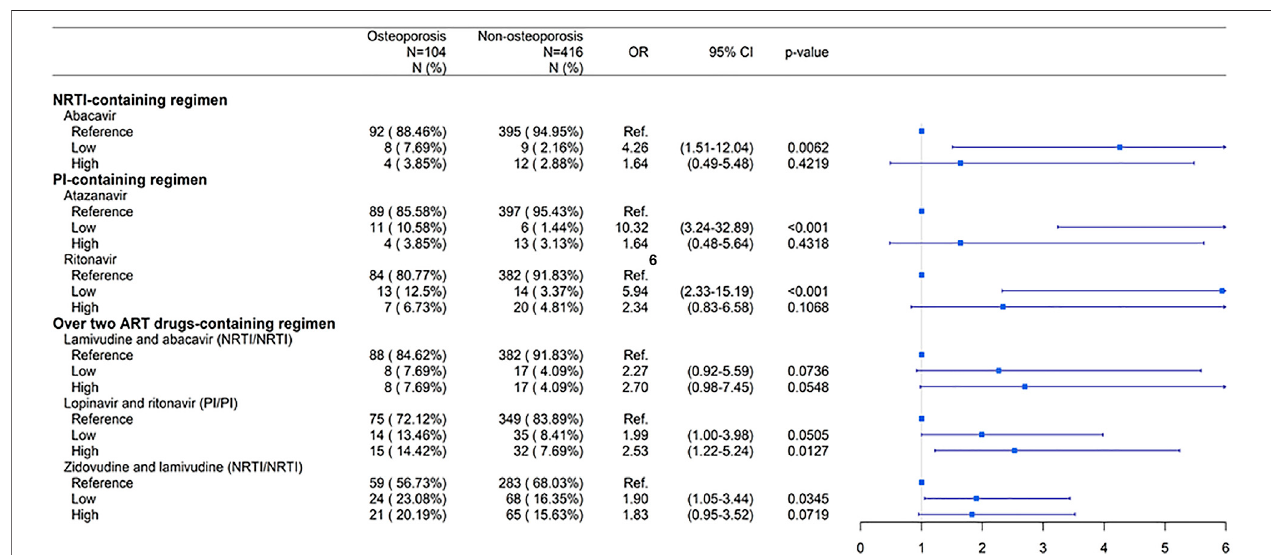
FIGURE 4 | Dose-response relationship between individual ART drugs and risk of osteoporosis compared to non-ART use. Low: low cumulative de fi ned daily doses (DDDs) < 2500; High: high cumulative DDDs ≥ 2500. Abbreviations: ART, antiretroviral therapy; NRTI, nucleoside/nucleotide reverse transcriptase inhibitor; PI, protease inhibitor; N, number; OR, odds ratio; CI, con fi dence